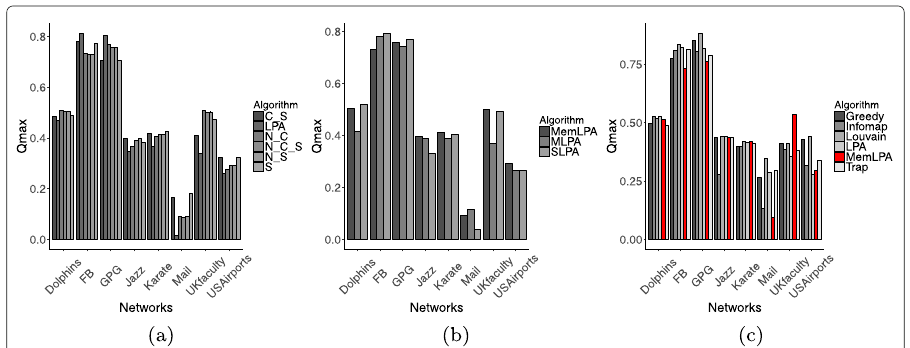
Fig. 6 Experiments on real-world networks. Each barplot represents the results obtained for all algorithms on a specific network. Experiments have been run 100 times and results